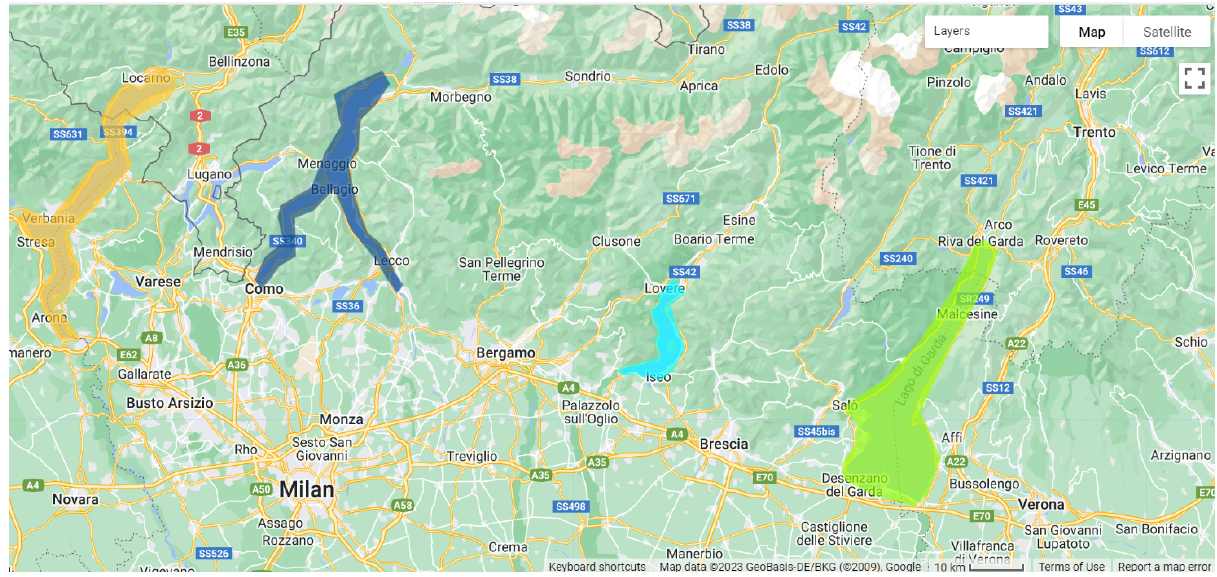
Figure 1. The location of four selected lakes (lake Maggiore highlighted as yellow, Como as dark blue, Iseo as light blue, and Garda as green) on the Google Earth Engine